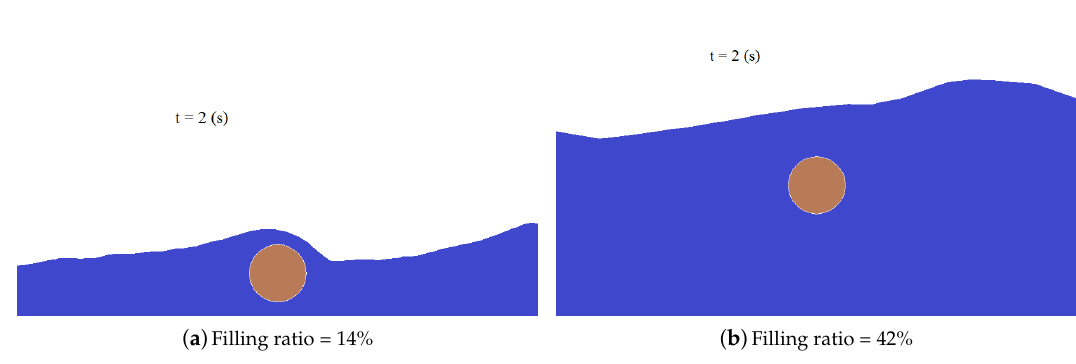
Figure 10. Free surface elevation of the fluid at various filling levels.